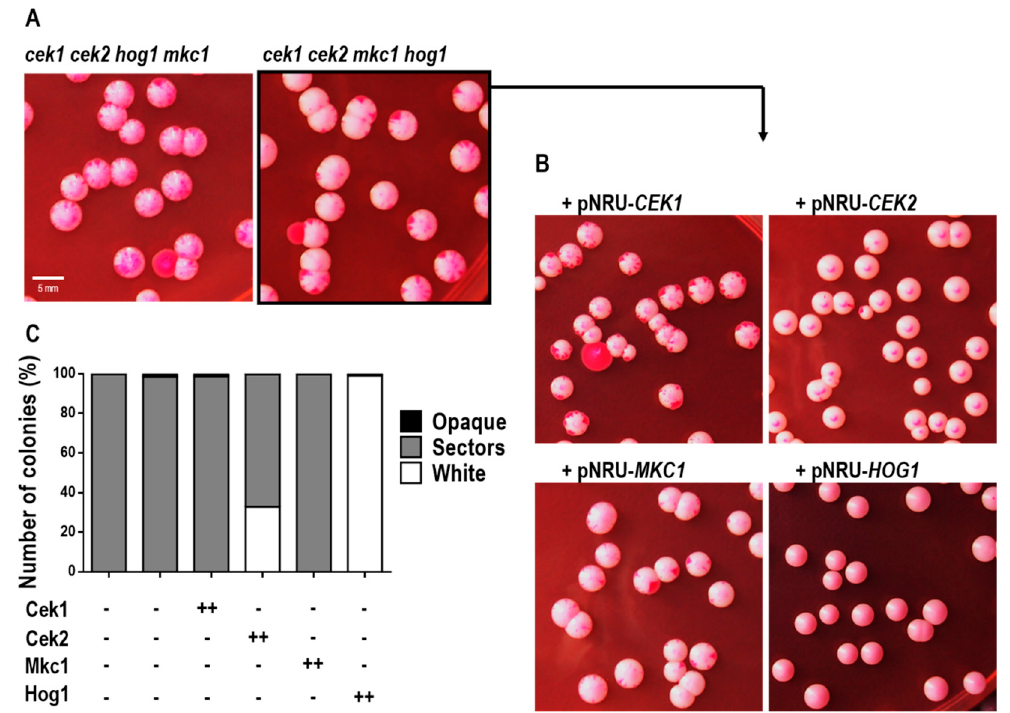
Figure 7. White-opaque switching of C. albicans strains lacking MAPKs. The quadruple mutant ( cek1 cek2 mkc1 hog1 ) was transformed with the plasmid pNRU carrying the CEK1 , CEK2 , MKC1 or HOG1 genes and the obtained strains were analyzed. Cells from white colonies grown on YPD at 30 ◦ C were inoculated on YPD agar plates supplemented with phloxine B. ( A ) and ( B ) Representative pictures of colonies morphology of the indicated strains, from four independent experiments, taken after 8 days growth at room temperature (RT) ( < 21 ◦ C). ( C ) Summary graphic showing the percentage of white, opaque or white colonies with opaque sectors observed upon 12 days of growth at RT. At least 400 colonies from two independent experiments were analyzed. - stands for gene disruption and ++ for strains expressing ectopically (at ADH1 locus) a single copy of the MAPK gene. All pictures were taken at the same magnification. Scale bar = 5